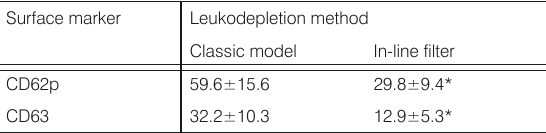
The total cell number was detected by automated cell sorter as described in the section on material and methods. Results are presented as mean±SD. * p<0.0001 compared to corresponding control. Table 2. The effect of various methods of leukodepletion on CD62p and CD63 expression in human platelets.